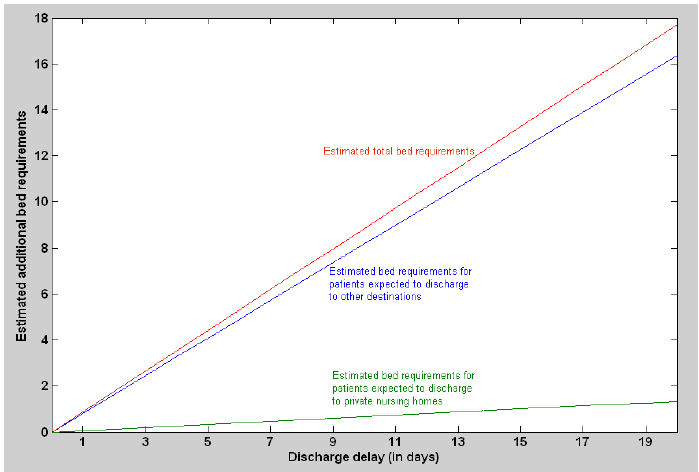
Figure 9. The estimated number of additional beds required for patients with each expected discharge destination in the stroke care unit with respect to the discharge delay (after 1000 days).